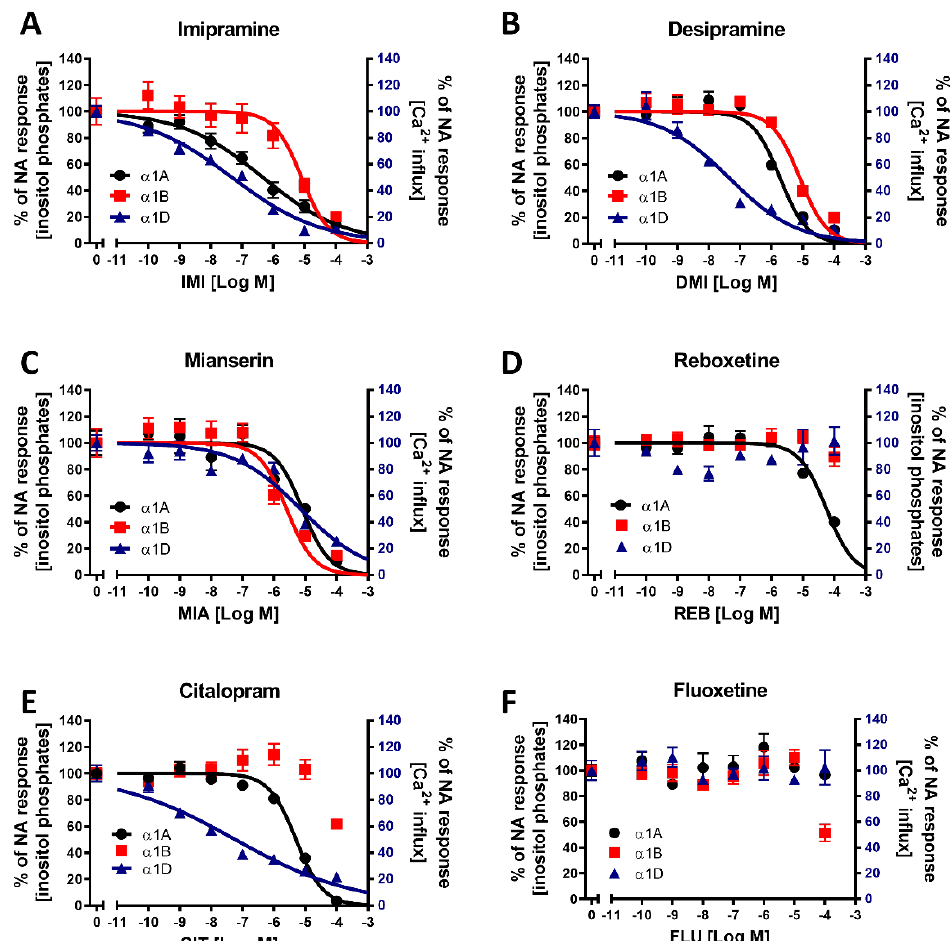
Figure 3. Inhibitory effects of antidepressants on noradrenaline-stimulated second messenger activation. Cells were incubated with varying concentrations of selected antidepressant drugs (imipramine ( A ), desipramine ( B ), reboxetine ( C ), mianserin ( D ), citalopram ( E ), and fluoxetine ( F )) and noradrenaline at submaximal concentrations (EC 90 ). Data are expressed as a percentage of noradrenaline-stimulated second messenger accumulation (inositol phosphate synthesis in PC-12 cell lines expressing α 1A- and α 1B-AR and calcium ion influx from ChemiSCREEN™ Ready-to-Assay™ α 1D cells). Each value represents the mean ± S.E.M. of at least three independent experiments conducted in duplicate. Table 1. The effects of drugs in cells with cloned α 1-AR subtypes. The IC 50 values were determined by nonlinear regression analysis from the dose–response curves in the cells expressing each subtype of α 1-AR after stimulation with noradrenaline at the EC 90 concentration. Each value is the mean and SEM from at least three independent experiments in duplicate. IMI—imipramine;